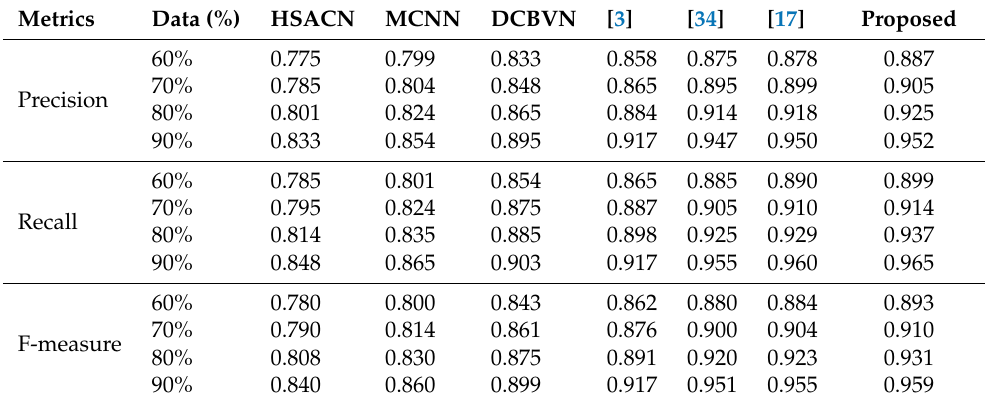
Table 3. Comparative analysis of Sentiment Classification for Yelp 2014 dataset in terms of precision, recall and